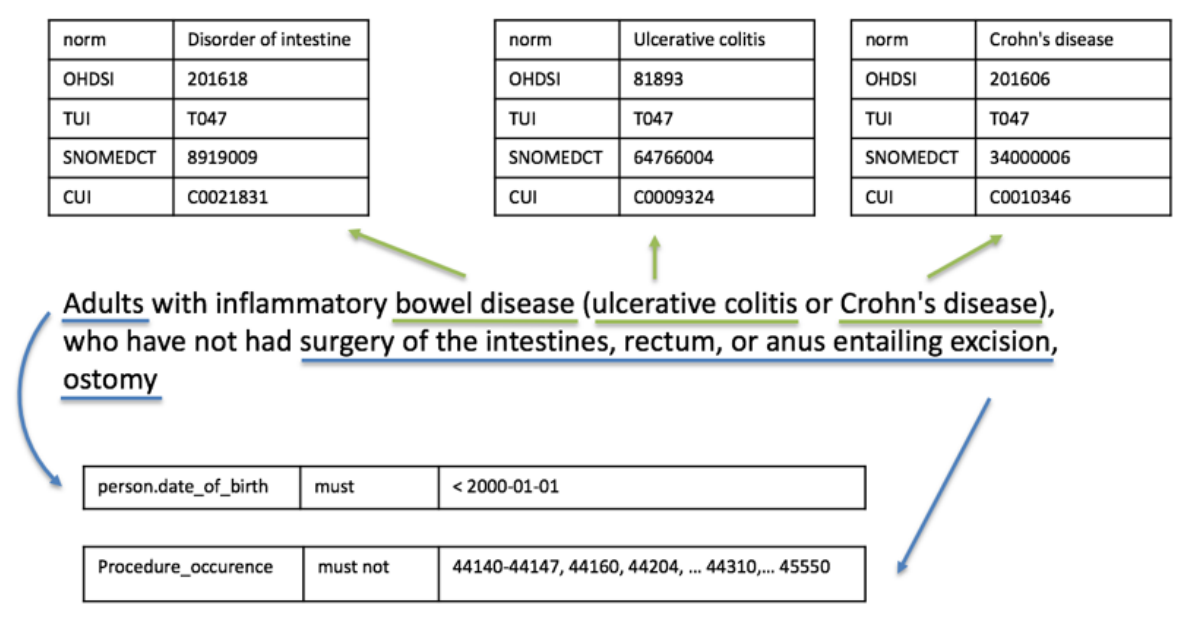
Figure 3. Textual query modeling example. CUI: concept unique identifier; OHDSI: Observational Health Data Sciences and Informatics;